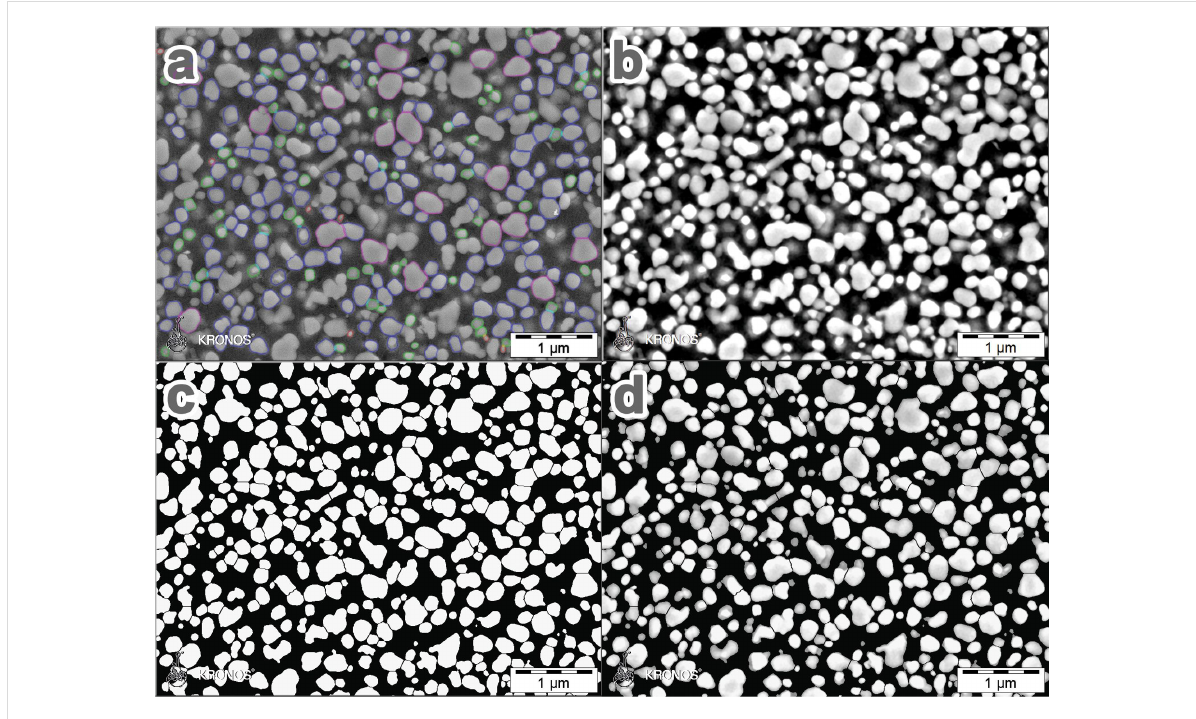
Figure 2: Imaging conditions and image post-processing for pigment sizing for a rutile pigment; a) original image superimposed with the outlines of the finally evaluated particle sections after grey-value and shape filtering; b) unified image after noise reduction and shading correction; c) binarised image after application of a watershed transform and connectivity filter; d) filtered image (b) masked with binarised image (c); automated detection applied to image d.